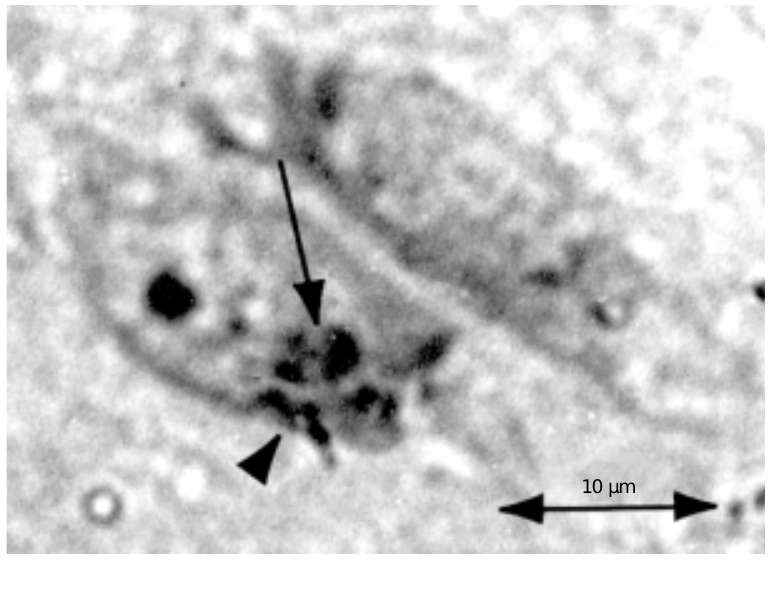
Figure 4. Tyrosine hydroxylase (TH)-labeled neurons from NMRI mice at 21 days after intravenous infection with 5 x 10 6 colony forming units of Nocardia otitidiscaviarum (GAM-5) showing neurological mani- festations (experimental mice), and from control non- infected mice. Scanning confocal laser micrographs of immunofluorescent neurons from: a) substantia nigra pars compacta (SNpc) of control animals, b) SNpc of experimental animals, c) ventral tegmental area (VTA) of control animals, and d) VTA of experimental animals. Note the large decrease in the number of TH-positive neurons in the SNpc of the experimental group (b) compared to control (a), as well as a decrease in the number of TH-positive neurons in the VTA of infected mice (d) compared to control